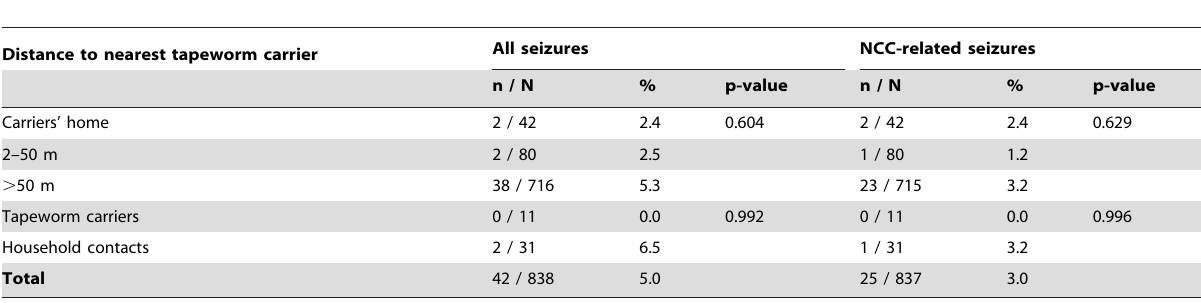
Distance to nearest tapeworm carrier